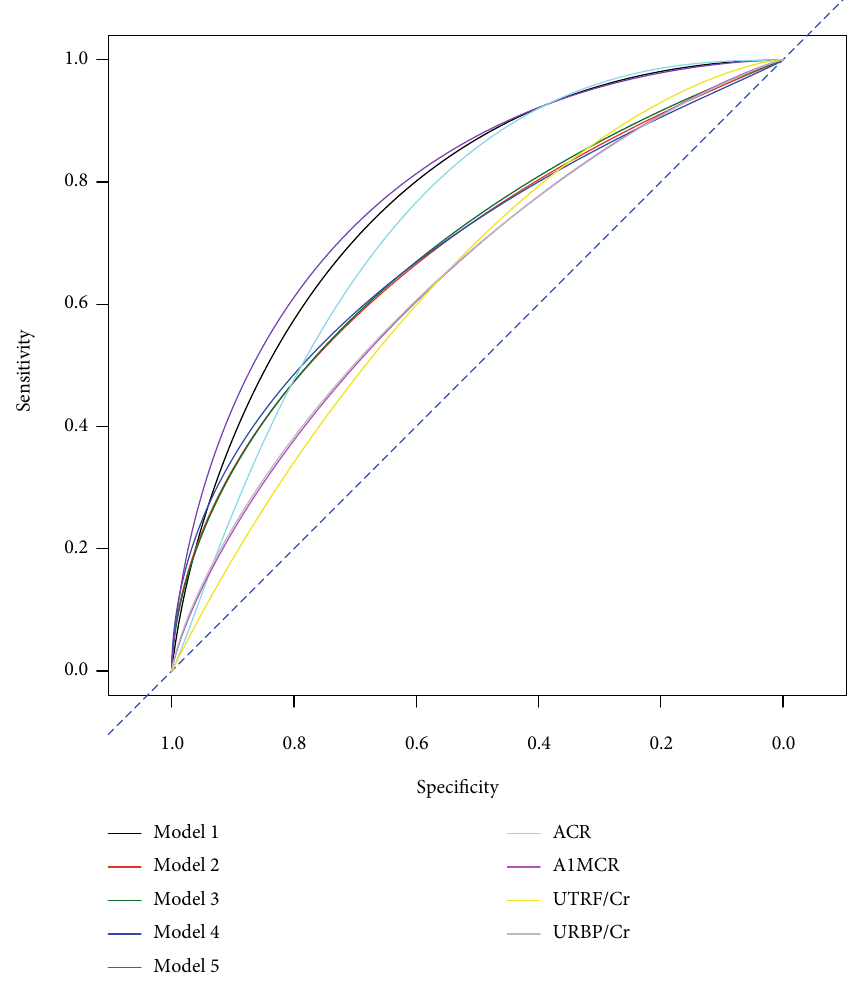
Figure 3: The smooth ROC curves of di ff erent models for predicting the risk of new-onset renal dysfunction. Model 1: combined analysis of age, HbA1c, hypertension, and ACR; Model 2: combined analysis of age, HbA1c, hypertension, and A1MCR; Model 3: combined analysis of age, HbA1c, hypertension, and UTRF/Cr; Model 4: combined analysis of age, HbA1c, hypertension, and URBP/Cr; Model 5: combined analysis of age, HbA1c, hypertension, ACR, A1MCR, UTRF/Cr, and URBP/Cr. ACR: albumin-to-creatinine ratio; A1MCR: alpha-1- microglobulin-to-creatinine ratio; UTRF/Cr: transferrin-to-creatinine ratio; URBP/Cr: retinol-binding protein-to-creatinine ratio.